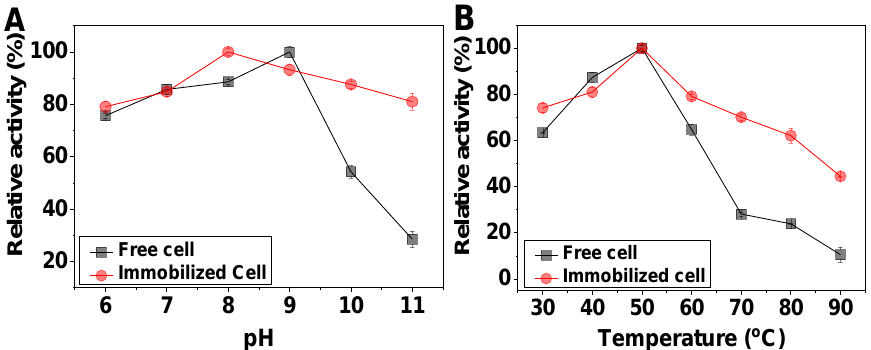
Figure 4. Effects of (A) pH and (B) temperature on the activities of the free and immobilized cells. All the experiments were repeated three times, and the standard deviation was calculated and presented as error bars.